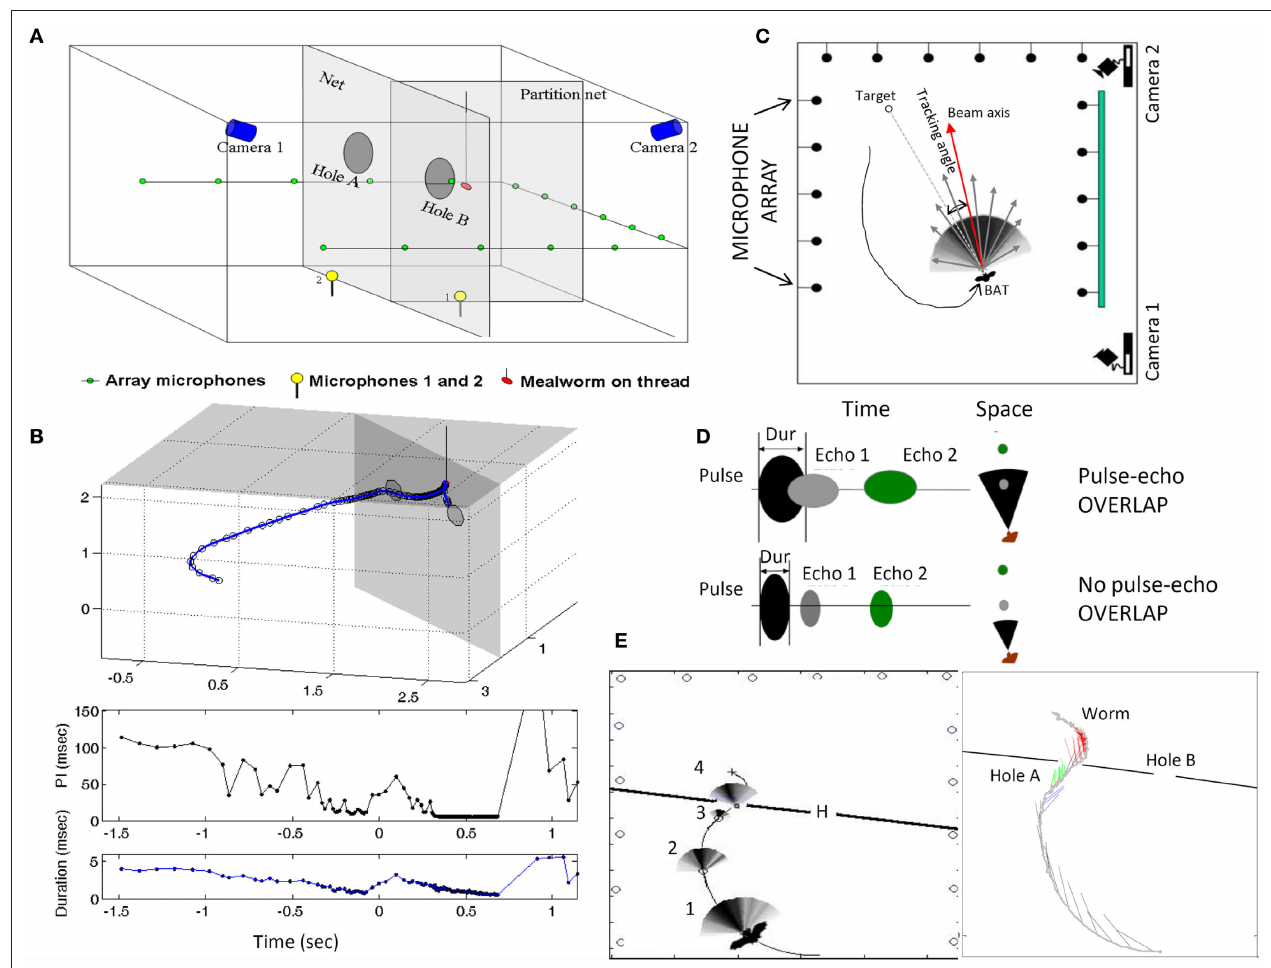
Figure 3 | Contains schematics illustrating the experimental setup and recording methods in the obstacle avoidance/insect capture task (top). (A) The bat was trained to fly through one of two openings in a net that was stretched across the room (see top left diagram). Behind one of the openings, a food reward (tethered mealworm) was presented. Two high-speed IR sensitive video cameras recorded the positions of the obstacles, prey and the bat’s flight behavior, which were later used for off-line analyses. Microphones on the floor recorded the full bandwidth of the bat’s sonar signals. A microphone array, positioned along three walls, was used to reconstruct the bat’s sonar beam pattern. (B) , above, show the bat’s 3D flight path through the net and to intercept the tethered insect, and, below, the corresponding changes in the duration and interval between successive sonar calls. Zero on the x -axes of these plots marks the time when the bat passes through the net opening. More details on the